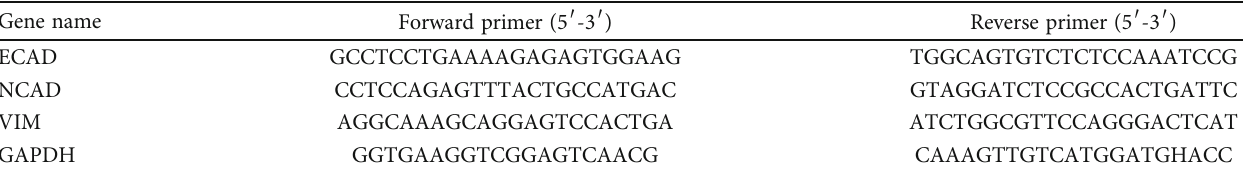
Figure 1: Schematic diagram of transwell coculture system and transwell migration assay. (a) Schematic diagram of the 0.4 μ m pore insert of the transwell coculture system. (b) Schematic diagram of the 8.0 μ m pore insert of the transwell migration assay. Table 1: mRNA primer